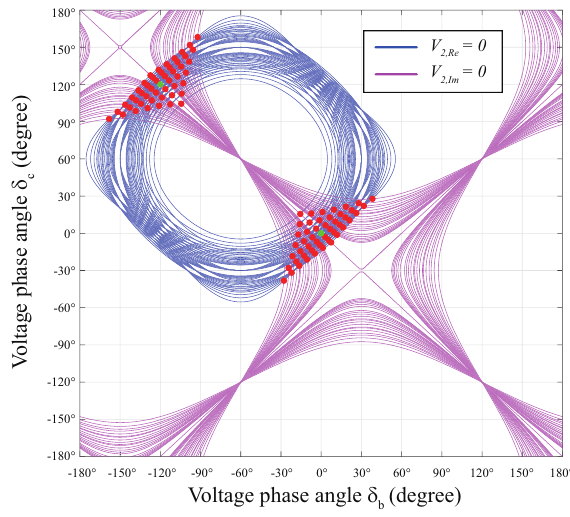
Figure 8. An example of undetectable unbalance points.